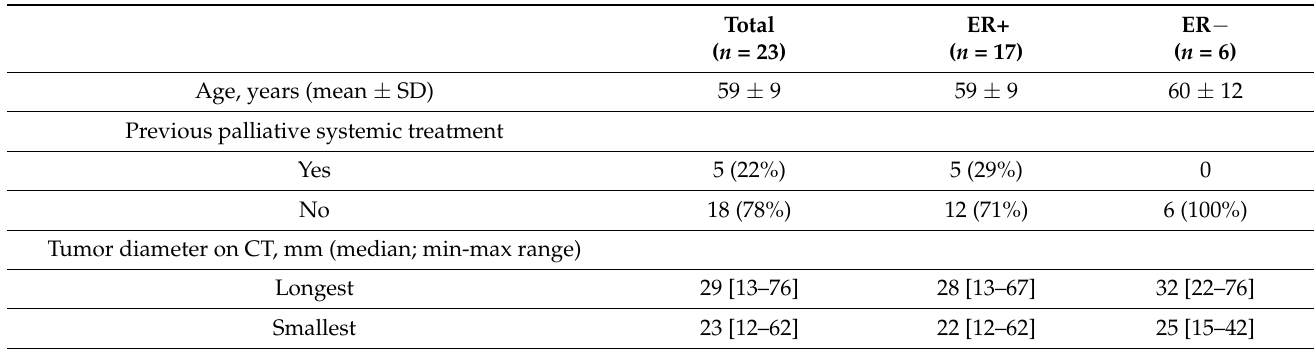
Table 1. Baseline characteristics